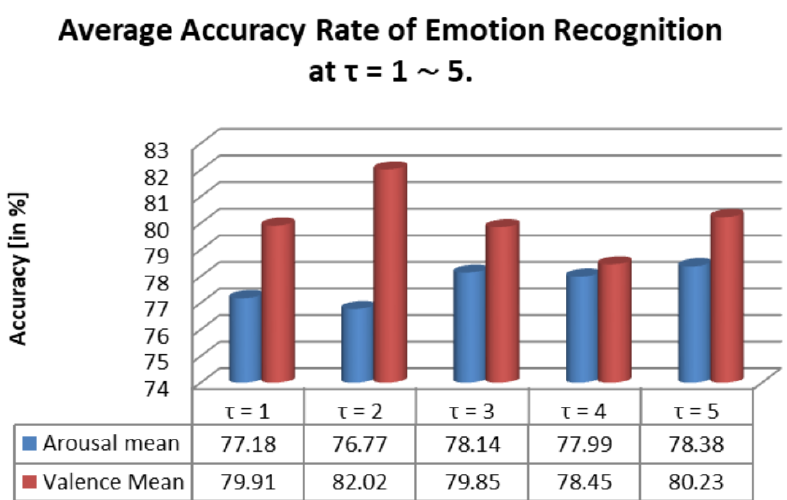
Figure 10. Calculation of average accuracy of emotion recognition with τ -values of other studies. Table 5. Comparative analysis of current work with other existing related